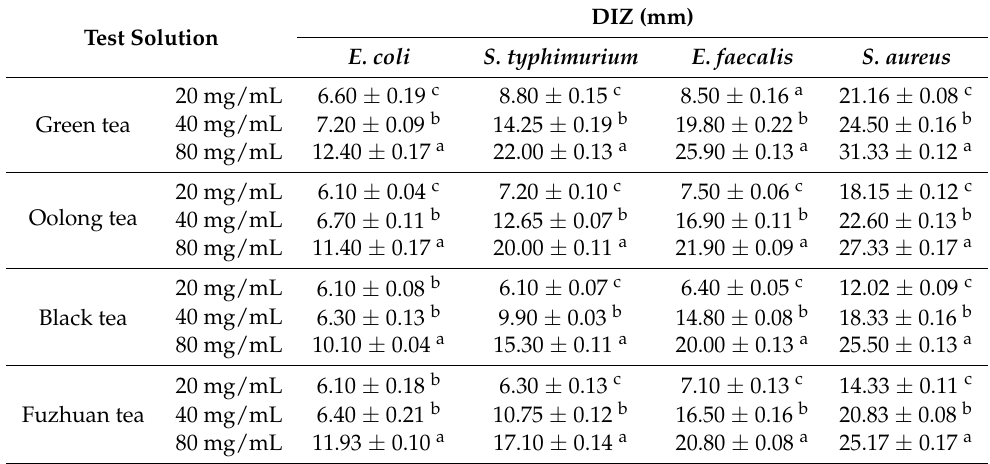
Table 1. DIZ of tea extracts against tested bacteria.